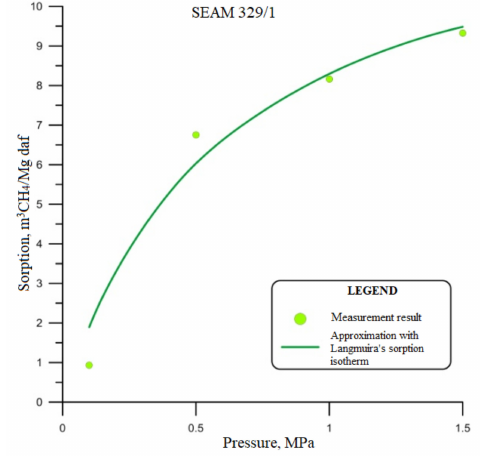
Figure 1. Isotherm of sorption (seam